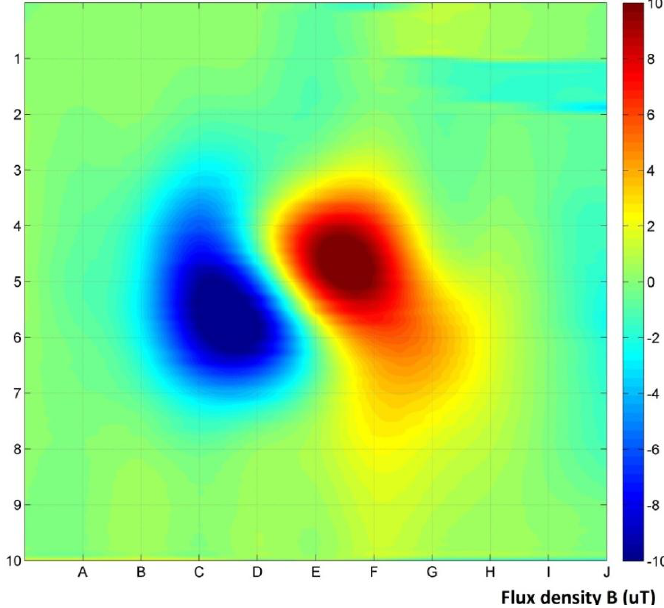
Figure 5. Gradient measurement results, 100 mm distance from the sample.